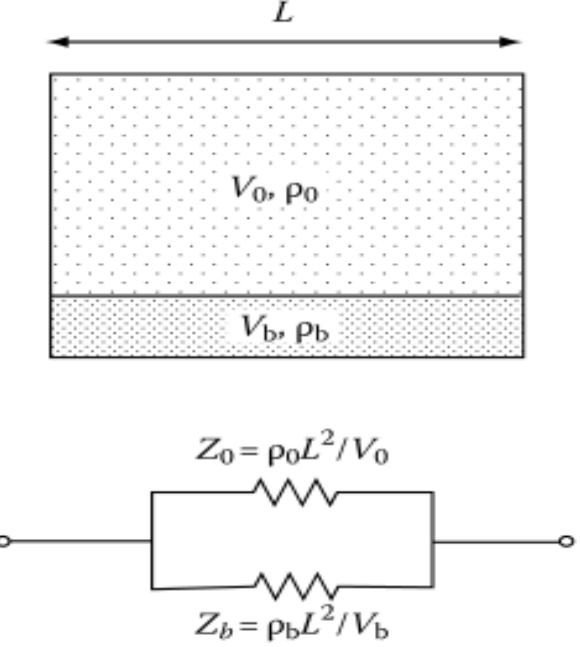
Figure 4. The parallel conductor model and the equivalent circuit, Where: V0, Vb The volume of kidney and blood respectively, ρ0, ρb— the electrical resistivity of kidney tissue and blood respec- tively.